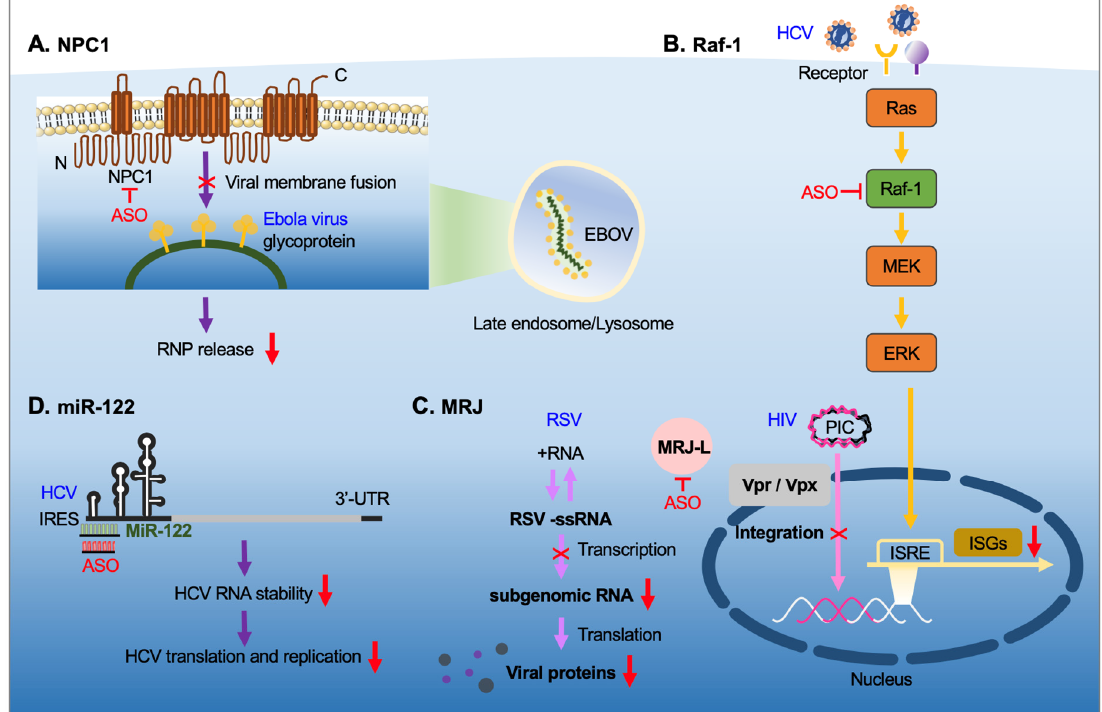
Figure 4. ASOs targeting host factors. Viruses take advantage of host factors for their life cycle. ( A ) NPC1 participates in membrane fusion and RNP release of Ebola virus. ( B ) Raf-1 signaling promotes HCV replication and suppresses antiviral immunity. ( C ) MRJ-L is required for the production of subgenomic RNA and mRNAs of RSV and facilitates the nuclear entry of the HIV preintegration complex. ( D ) miR-122 stabilizes the genome of HCV and promotes viral replication. Therefore, ASOs that suppress the expression of these host factors or block miRNAs can inhibit viral entry or viral genome amplification or protein production. Meanwhile, ASOs may restore antiviral activity of infected cells by suppressing the expression of certain viral or host factors. Abbreviations: ISRE, interferon-stimulated response element; ISG, interferon-stimulated gene; PIC, preintegration complex; IRES, internal ribosome entry